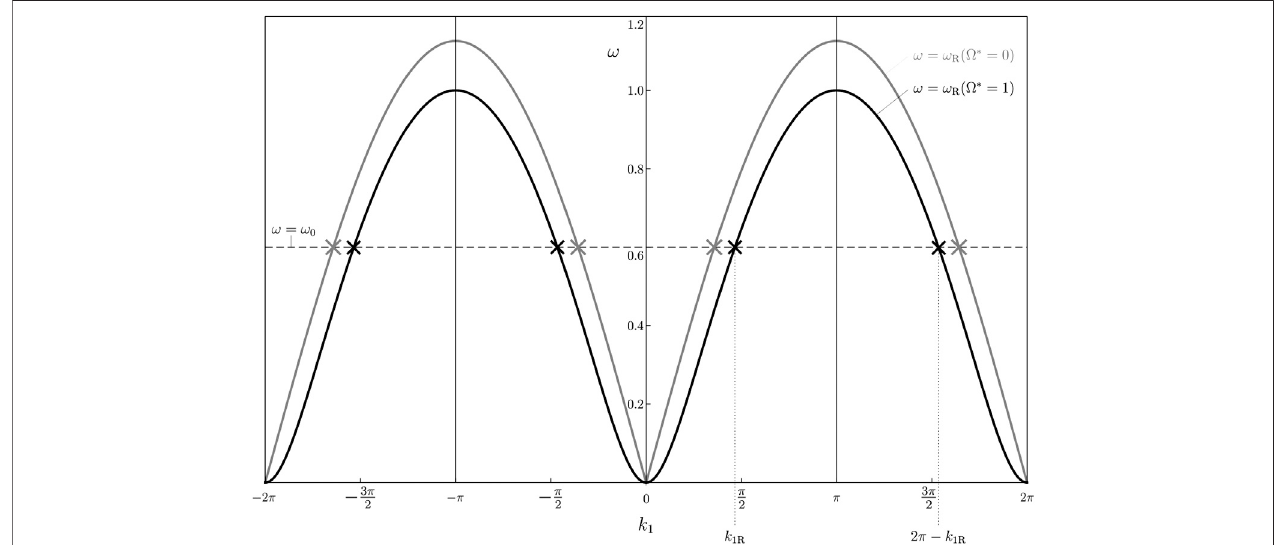
Ω * (cid:1) 1 ( Ω * (cid:1) 0) are represented by black (gray) crosses. The interval [− π , π ] is instead R for